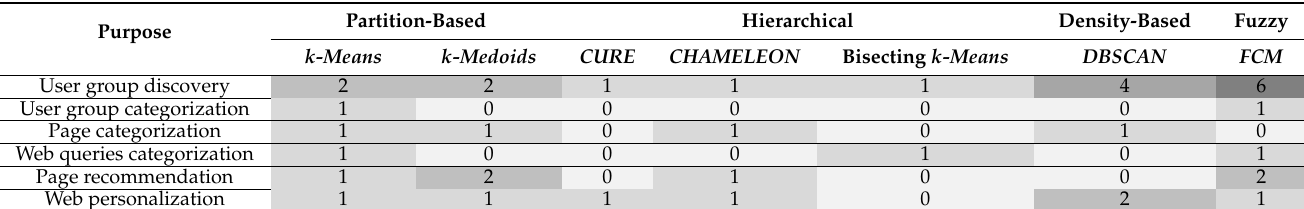
Table 7. Frequency heatmap of clustering purpose with respect to the clustering